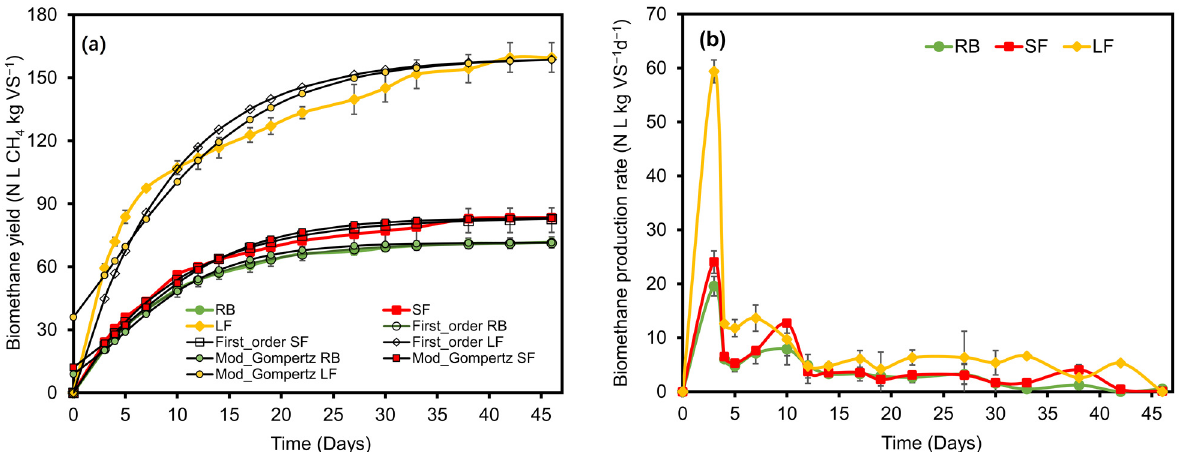
Figure 2. Biomethane yield ( a ) and biomethane production rate ( b ) of raw biomass (RB), solid fractions (SF), and liquid fractions (LF) of Sargassum spp. from the Mexican Caribbean. ( n = 3, error bars are standard deviation). Table 5. Results of kinetics study (first-order and modified Gompertz).